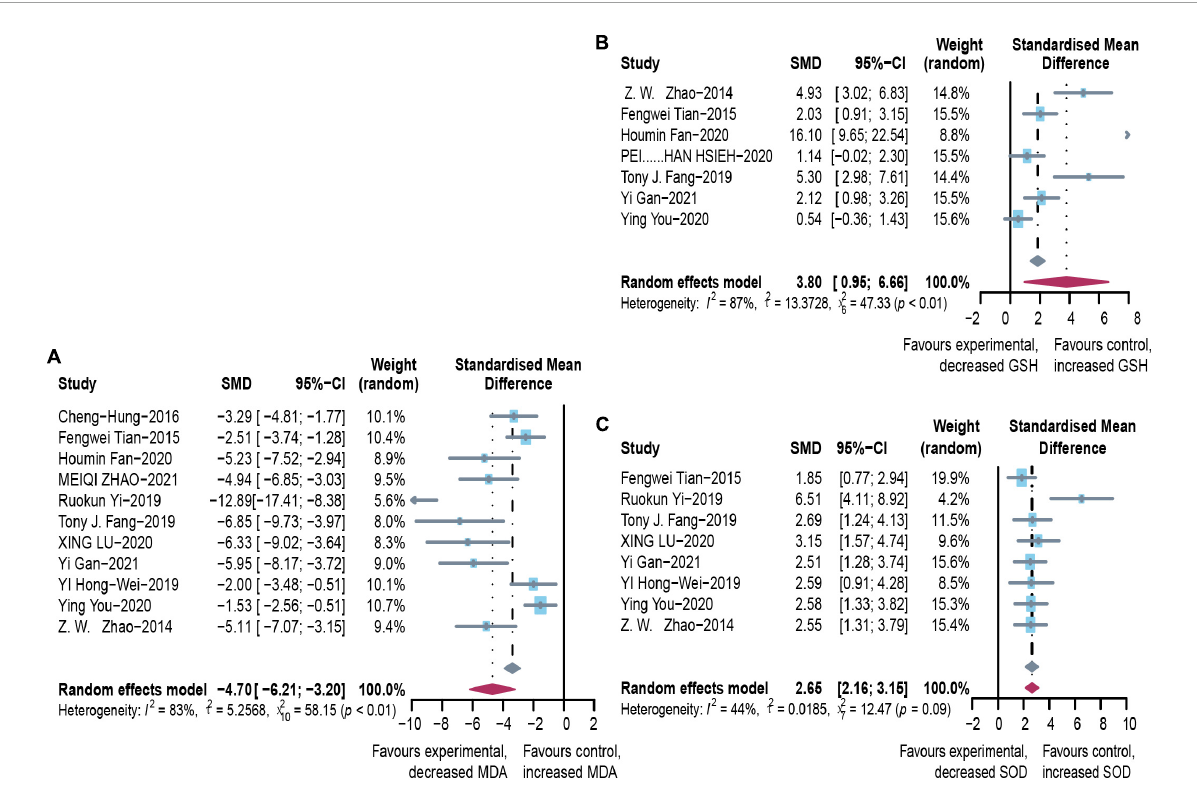
FIGURE6 Effectiveness of microbial agents on oxidative stress. (A) The effect of microbial agents on MDA to evaluate free radical mediated lipid peroxidation injury. (B,C) The effect of microbial agents on GSH and SOD to evaluate antioxidant status of tissues. SMD, Standardized mean difference; CI, Confidence